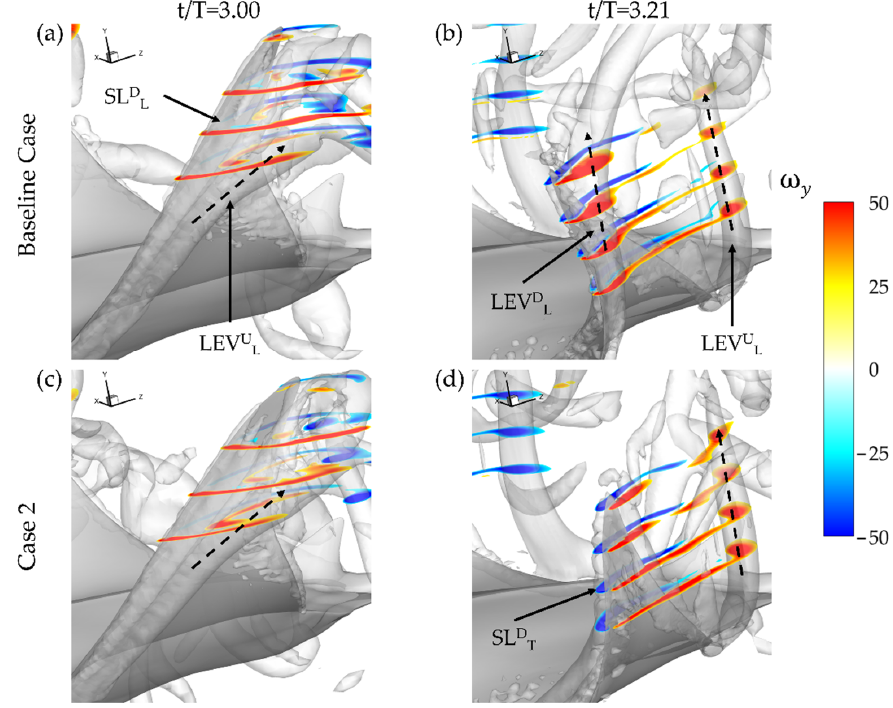
Figure 9. Spanwise vorticity plots for the baseline case (BR = 1.0 PR = 1.0) ( a , b ) and case 2 (BR = 1.0 PR = 0.67) ( c , d ) at t/T = 3.0 ( a , c ) and t/T = 3.21 ( b , d ).